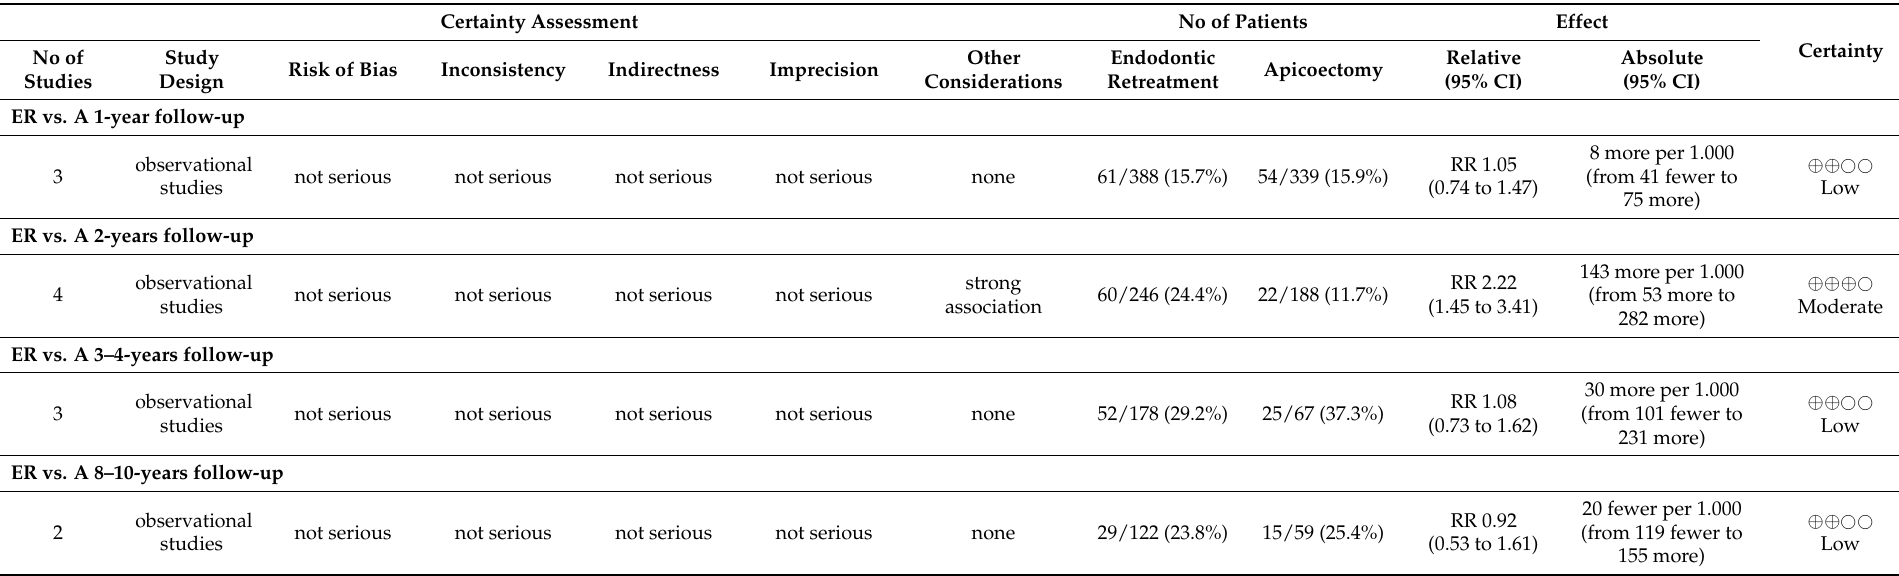
Table 4. Evaluation of GRADE pro GDT;